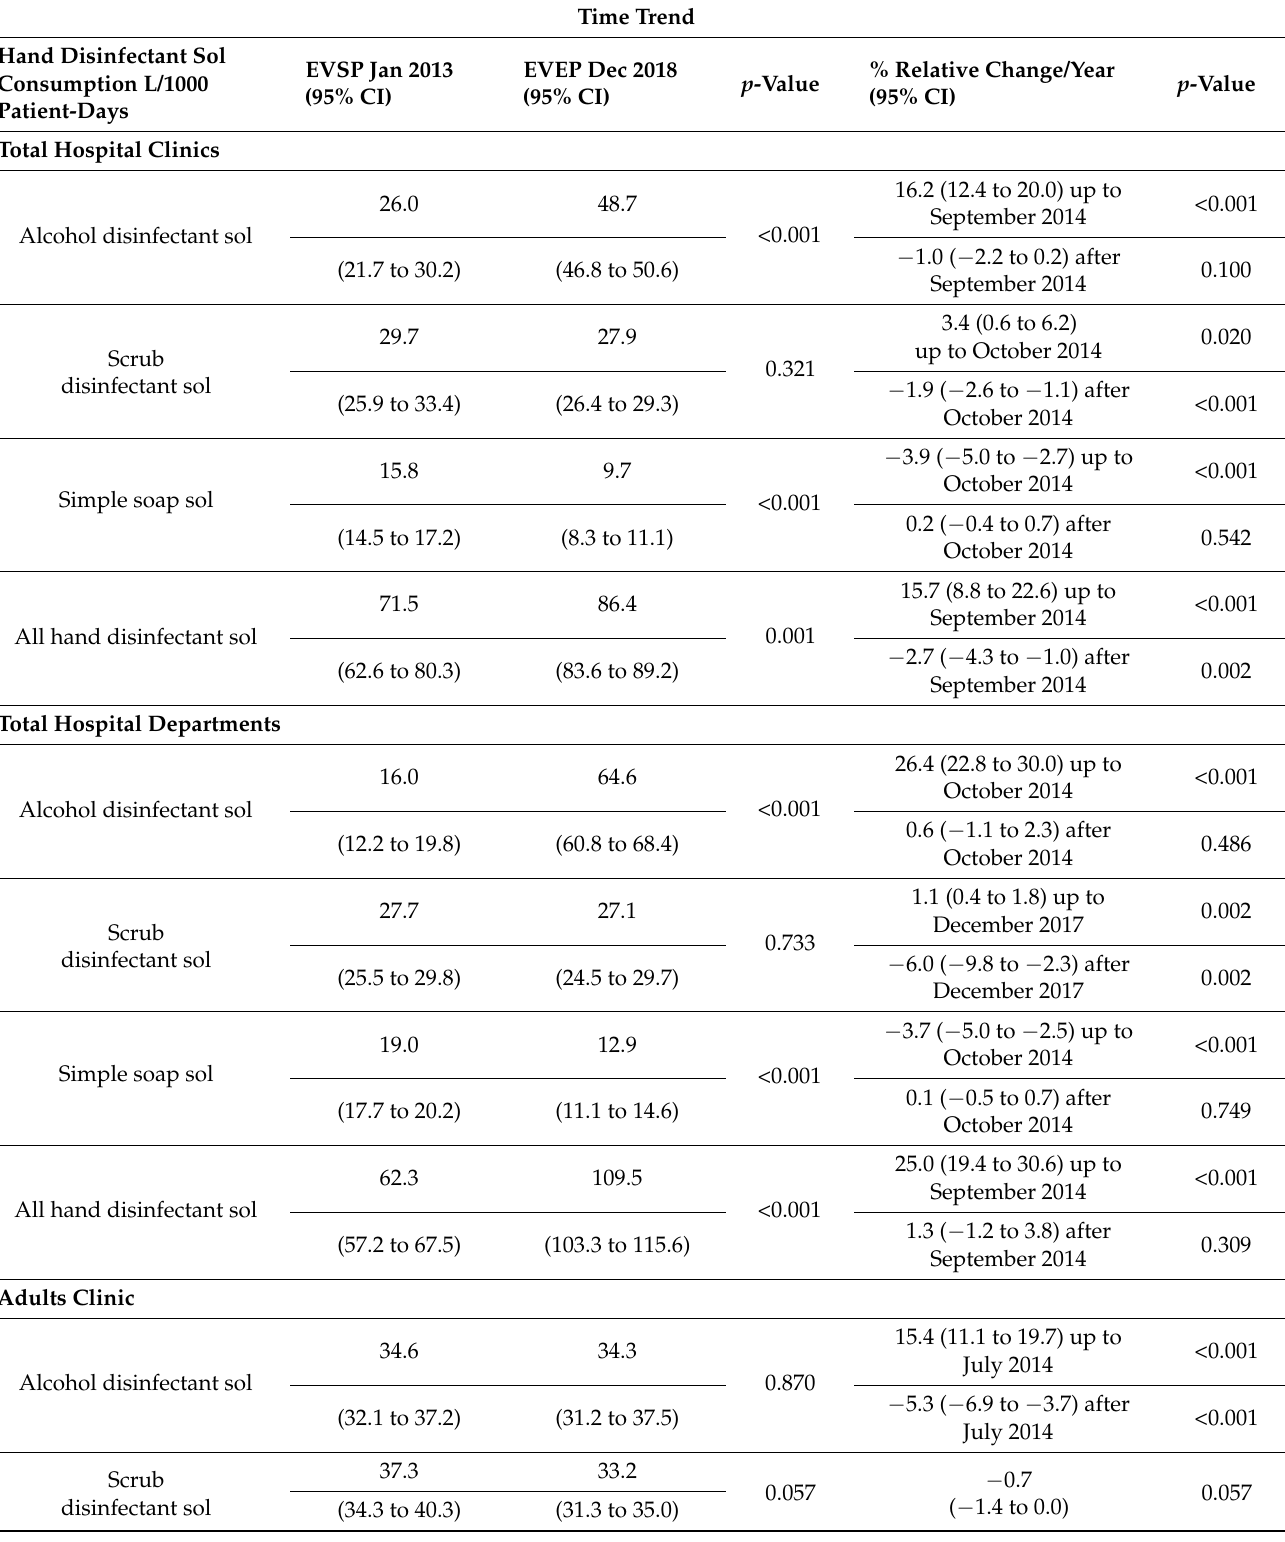
Table 3. Time trend of hand disinfectant solutions use in a hospital from January 2013 to Decem- ber